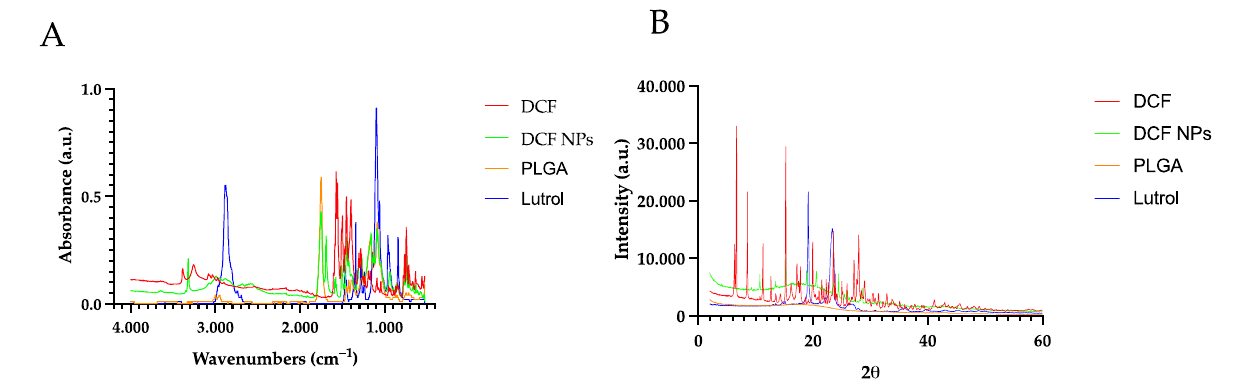
Figure 3. Interaction studies ( A ) FTIR spectra ( B ) XRD spectra.